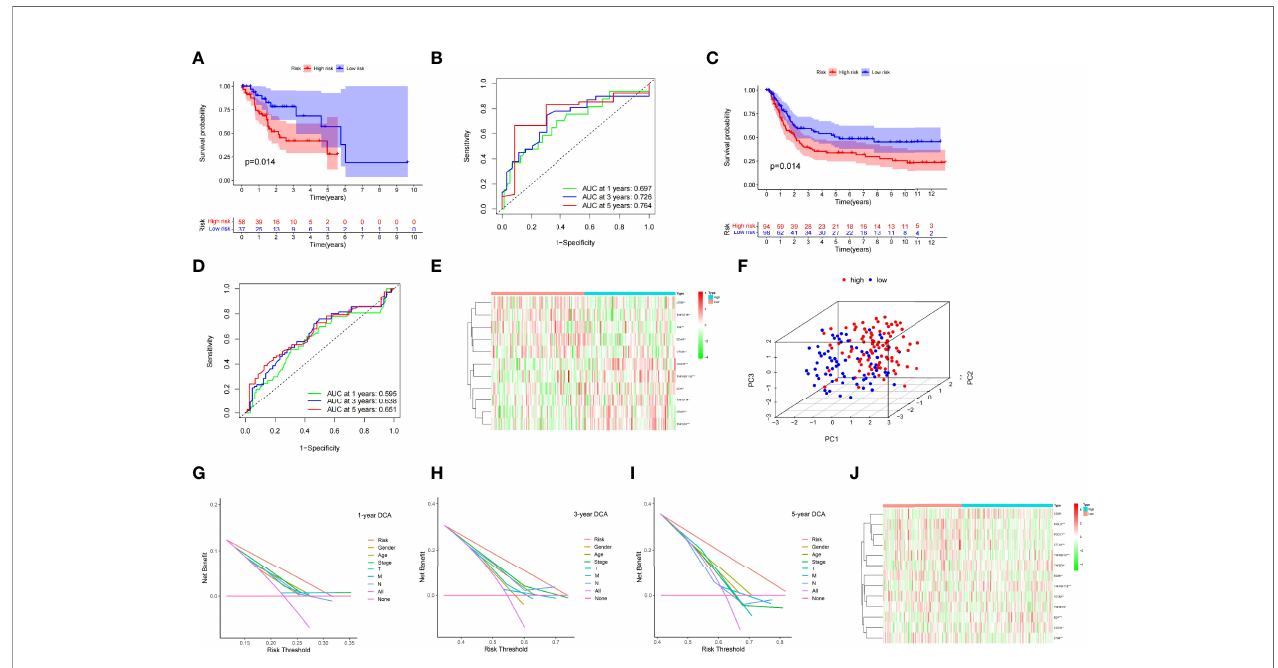
FIGURE 5 | Kaplan – Meier curves in the TCGA test cohort (A) and the GEO validation cohort (C) . TCGA test cohort (B) and GEO validation cohort (C) time- dependent receiver operating characteristic curves for the sensitivity and speci fi city of the prognosis assessment (D) . Gene set variation analysis of the GEO validation cohort (the unit of color bars is log2 (actual expression) +1) (E) . In the TCGA dataset, principal component analysis was used to evaluate the distribution patterns of the high- and low-risk patients (F) . Prognostic signature decision curve analysis at 1 (G) , 3 (H) , and 5 years (I) . Gene set variation analysis of the entire TCGA cohort (the unit of color bars is log2 (actual expression) +1) (J) (* p < 0.05, ** p < 0.01, *** p <